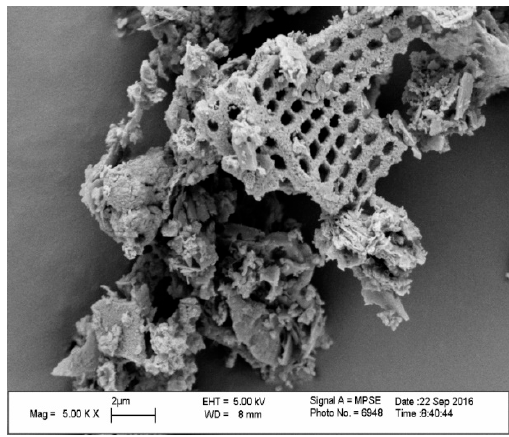
Figure 2. A SEM image of diatomite.